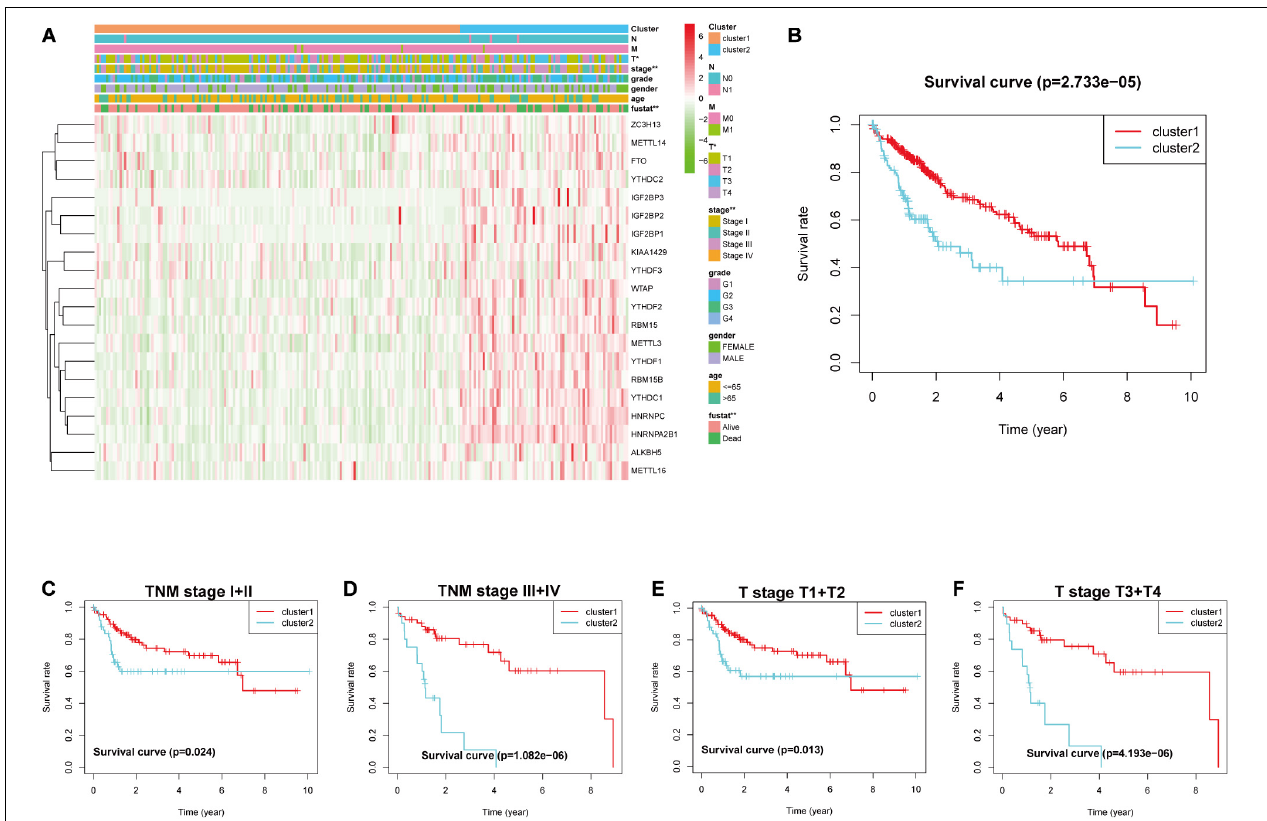
FIGURE 4 | Heatmap and clinical features in (A) cluster1 and cluster2, stratified by the m6A-related gene consensus analysis. (B) Kaplan–Meier survival curves for groups of clusters in LIHC. Kaplan–Meier OS curves for patients with (C) stage I + II and (D) III + IV in LIHC. Kaplan–Meier OS curves for patients with (E) stageT1 + T2 and (F) T3 + T4 in LIHC. LIHC, liver hepatocellular carcinoma; OS, overall